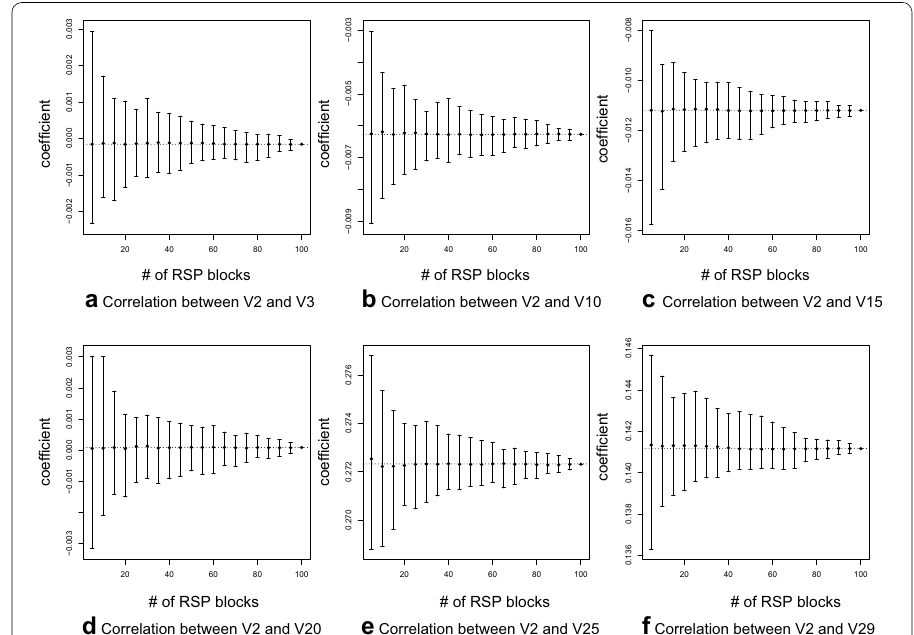
Fig. 6 Correlation between V2 and 6 other features in HIGGS. Incremental estimation of Pearson’s correlation coefficients between V2 and 6 other features using samples of RSP blocks of HIGGS data ( g = 5 ). The dotted line in each plot represents the coefficient computed from the entire HIGGS